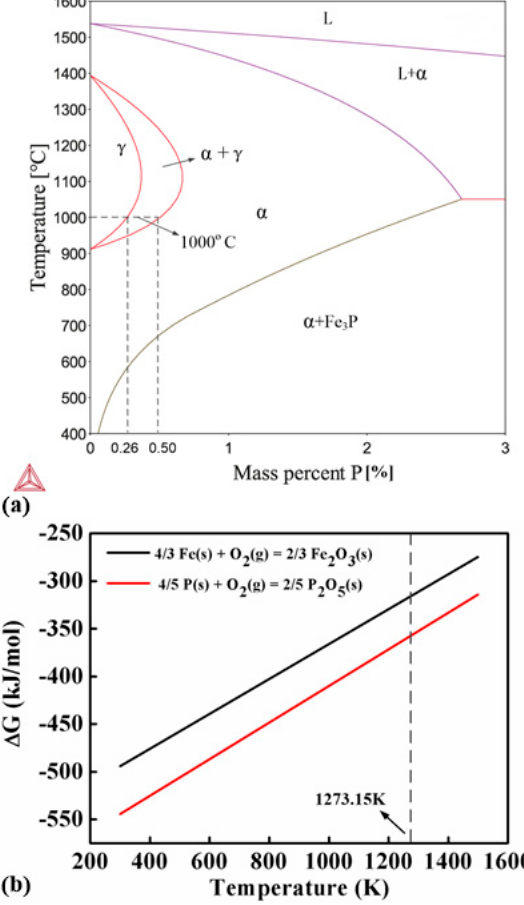
Figure 7. ( a ) Fe-P binary phase diagram showing that the ferrite can be stabilized by P addition and ( b ) Gibbs free energies ∆ G of the oxidation reactions of Fe and P suggesting that P is more prone to oxidization than Fe at the sintering temperature.